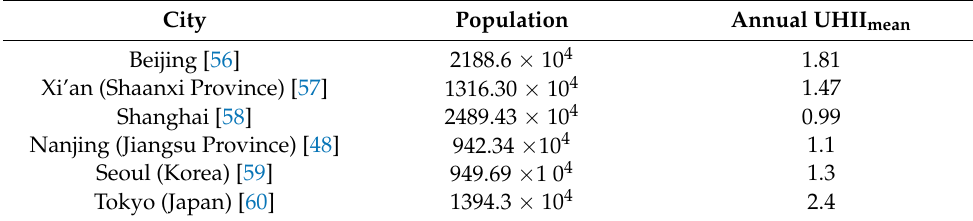
Table 9. Annual UHII mean of several cities ( ◦